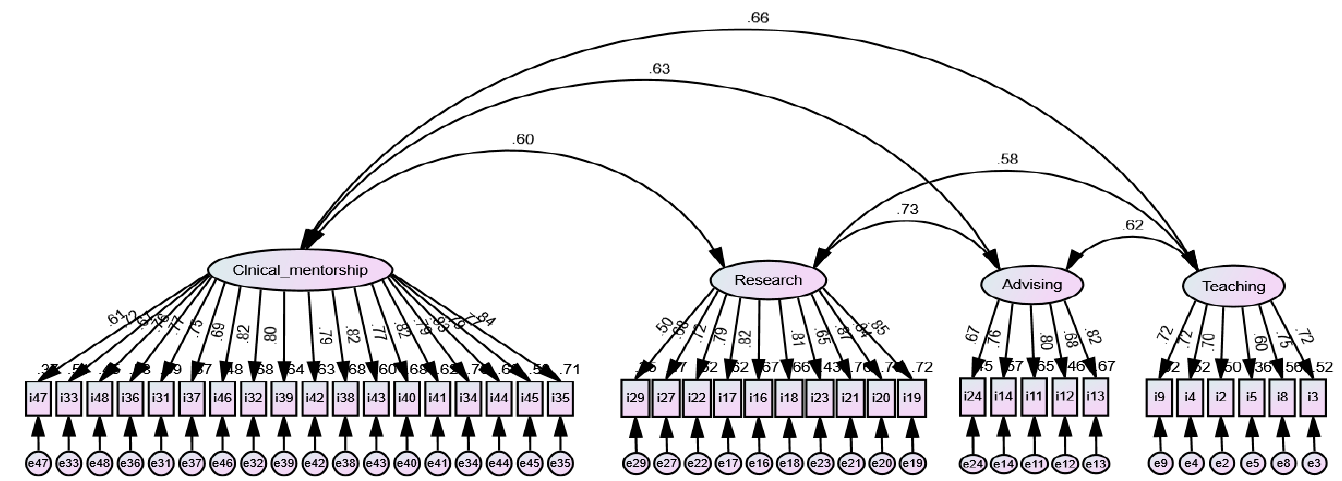
Figure 2. Confirmatory factor analysis for SSNER-SL.